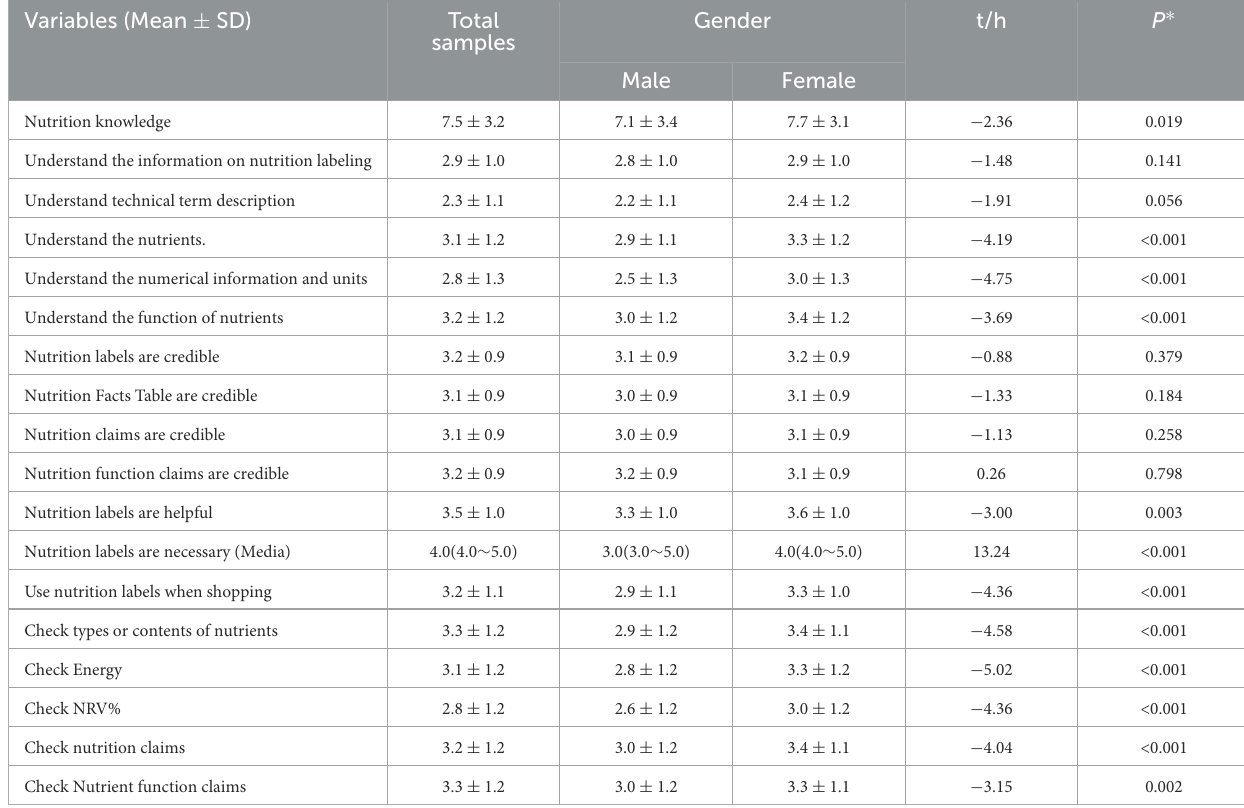
TABLE 2 Mean scores on knowledge, attitude, and practice scales completed by 636 residents, by gender. Variables (Mean ±